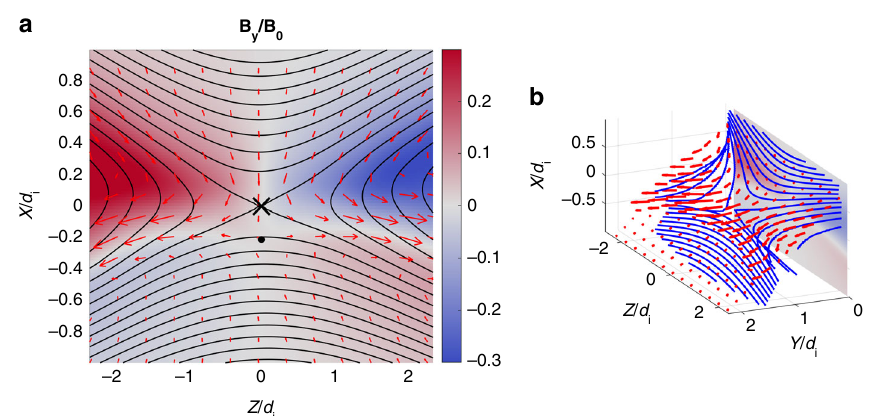
Fig. 8 Electron dynamics in the VPIC simulation. a The out-of-plane Hall magnetic fi eld is shown with sample in-plane fi eld lines electron fl ow vectors. The X marks the X-line and the dot marks the in-plane electron fl ow stagnation point, respectively. b A 3D representation of the magnetic fi elds lines